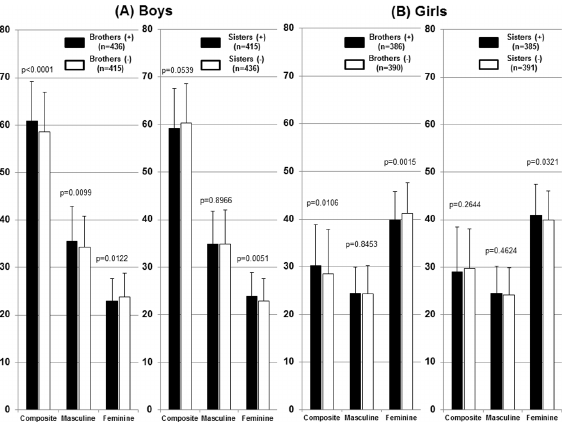
Fig 1. Effects of brothers or sisters on PSAI. (A) Boys. While the existence of brothers increased boy- typical behaviors and decreased girl-typical behaviors, that of sisters increased girl-typical behaviors in boys. (B) Girls. Girls with brothers exhibited fewer girl-typical behaviors due to the existence of brothers. Meanwhile, the existence of sisters increased girl-typical behaviors, even in girls.